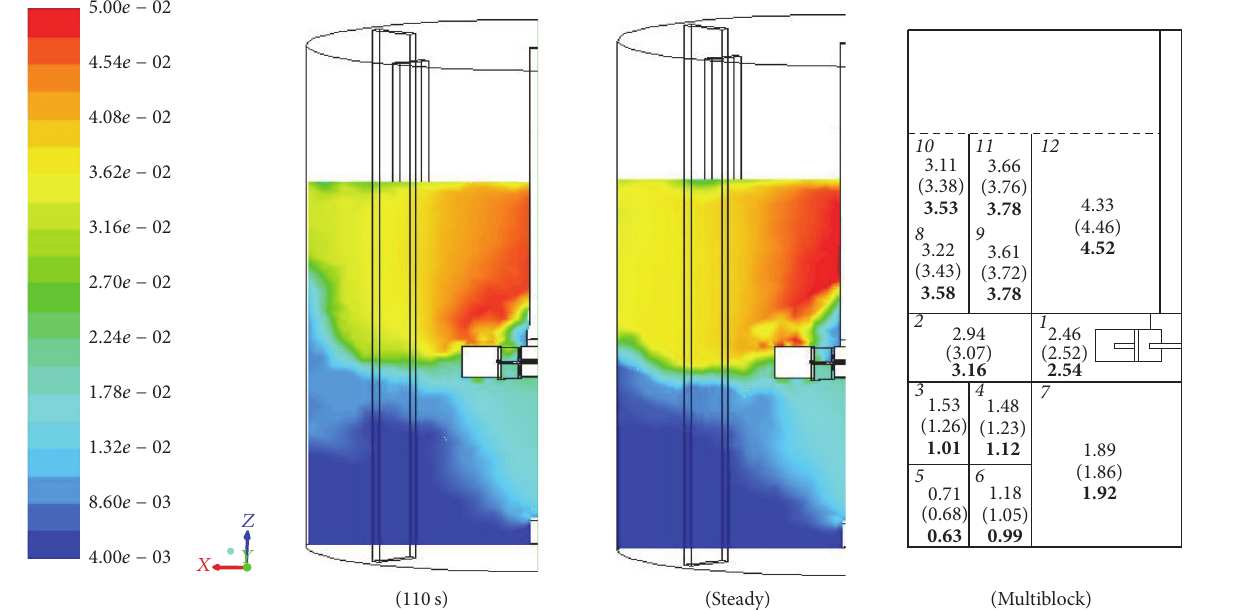
Figure 8: Contour of the SMD (in mm) of 𝑄 𝑔 = 0.065 vvm on the plane ( 𝑟/𝐷 𝑟 = − 0.5 ∼ 0.5, z/ 𝐷 𝑟 = − 0.5 ∼ 0.5, and 𝜃 = 45 ∘ ), 𝑁 = 250 rpm. Normal font (transient CFD), bracket font (steady CFD), and underline font (M-block model).